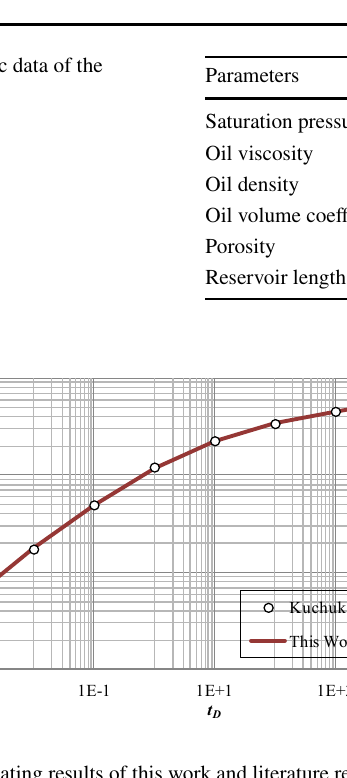
Fig. 4 Calculating results of this work and literature results